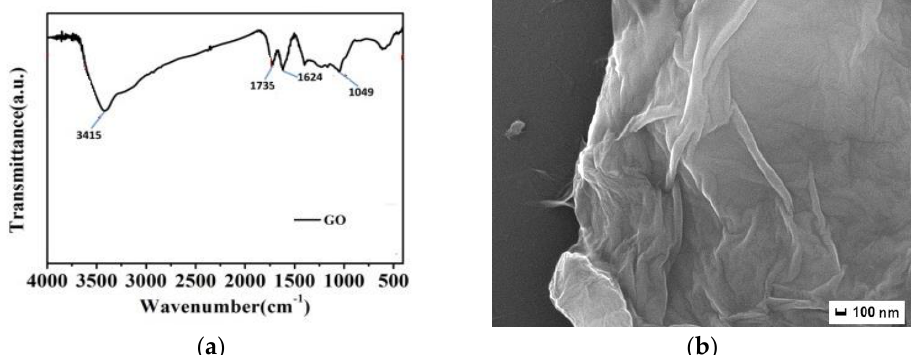
Figure 1. FT − IR spectrum ( a ) and scanning electron micrograph image (SEM) ( b ) of GO.